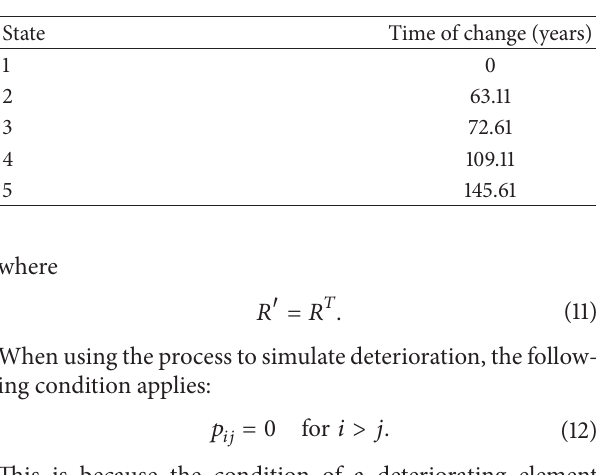
Table 2: Time at which condition states change (from Figure